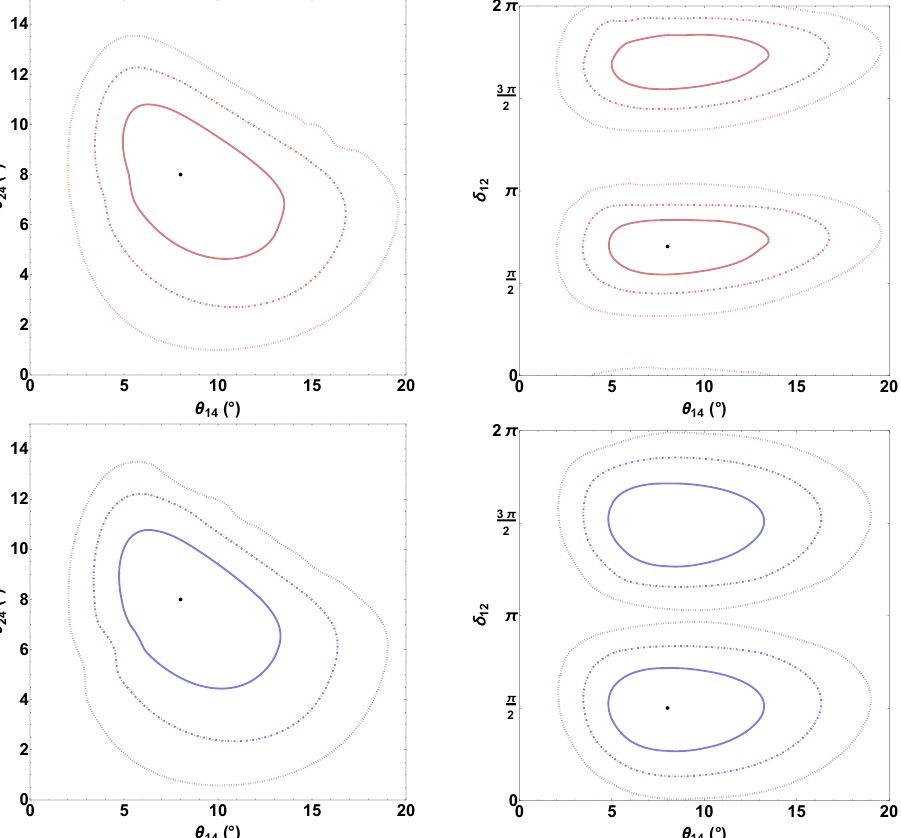
Figure 6 . 68% (solid lines), 95% (dashed lines) and 99% (dotted lines) contours in DUNE in the ( θ ) and ( θ ) planes when data are generated using 3+1 model best fits. The three 14 − θ 24 14 − δ 12 top (bottom) plots with red (blue) contours have been obtained using NO (IO) best